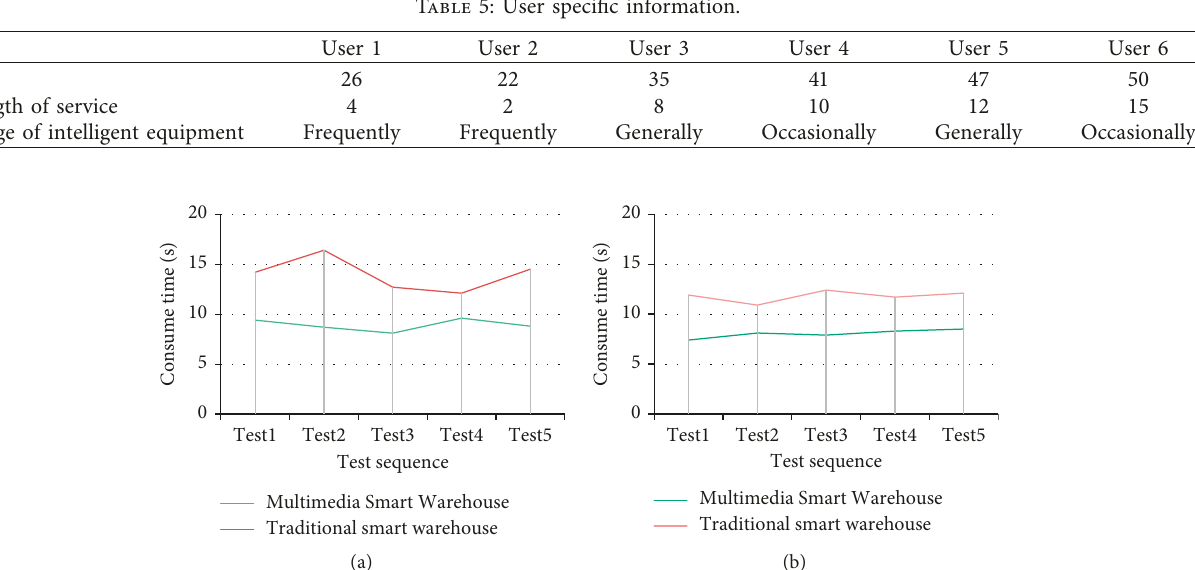
Figure 7: Smart warehousing in and out time. (a) shows the time it takes for each warehousing system to enter the warehouse. (b) shows the time it takes for each storage system to leave the warehouse.